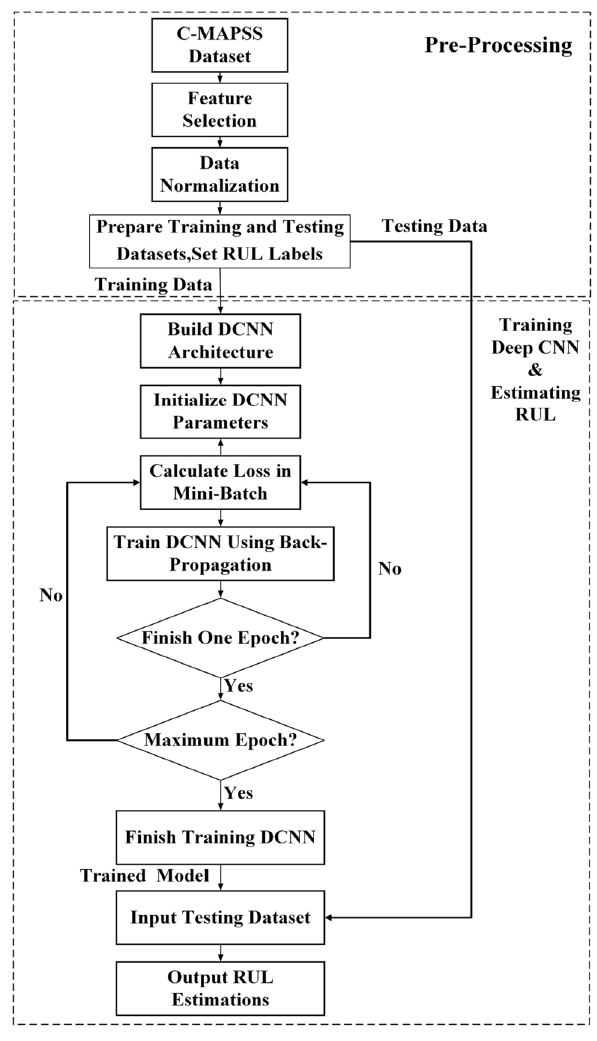
Fig. 10 The RUL prediction process of the tool